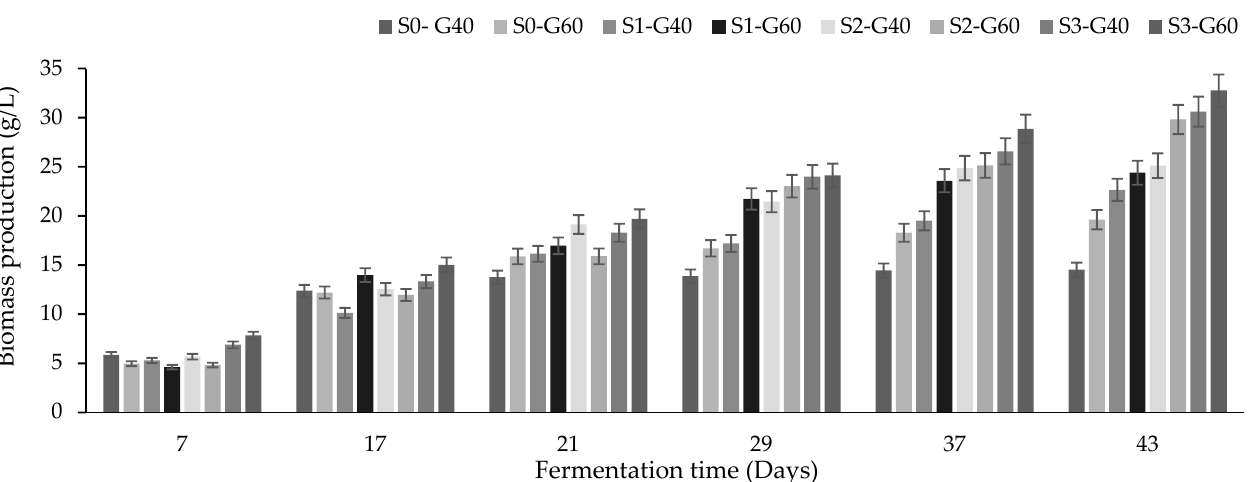
6 of 20 Table 3. Total results of biomass, IPS and lipids production, phenolic removal and decolorization of P. pulmonarius in batch-liquid state fermentation cultures, in synthetic media containing commer- cial glucose and OMWs with various phenolics concentrations. Representation of dry biomass (X, g/L), consumed glucose (Glc c , g/L), IPS (in g/L and w/w ) and total cellular lipids (L, in g/L and w/w ) at the following different fermentation points of each trial: ( a ) when the maximum biomass (X max , g/L) was produced; ( b ) when the maximum IPS amount (Y IPS/Xmax, g/L) was synthesized; ( c ) when the maximum IPS in dry weight (Y IPS/Xmax, %, w/w) value was achieved and ( d ) when the maximum total lipid in dry weight (Y L/Xmax, %, w/w ) value was recorded. Culture conditions: growth on 100-cc flasks, initial pH=5.6 ± 0.3, incubation temperature T =26 ± 2 °C. Each point is the mean value of three independent measurements. Culture Media *